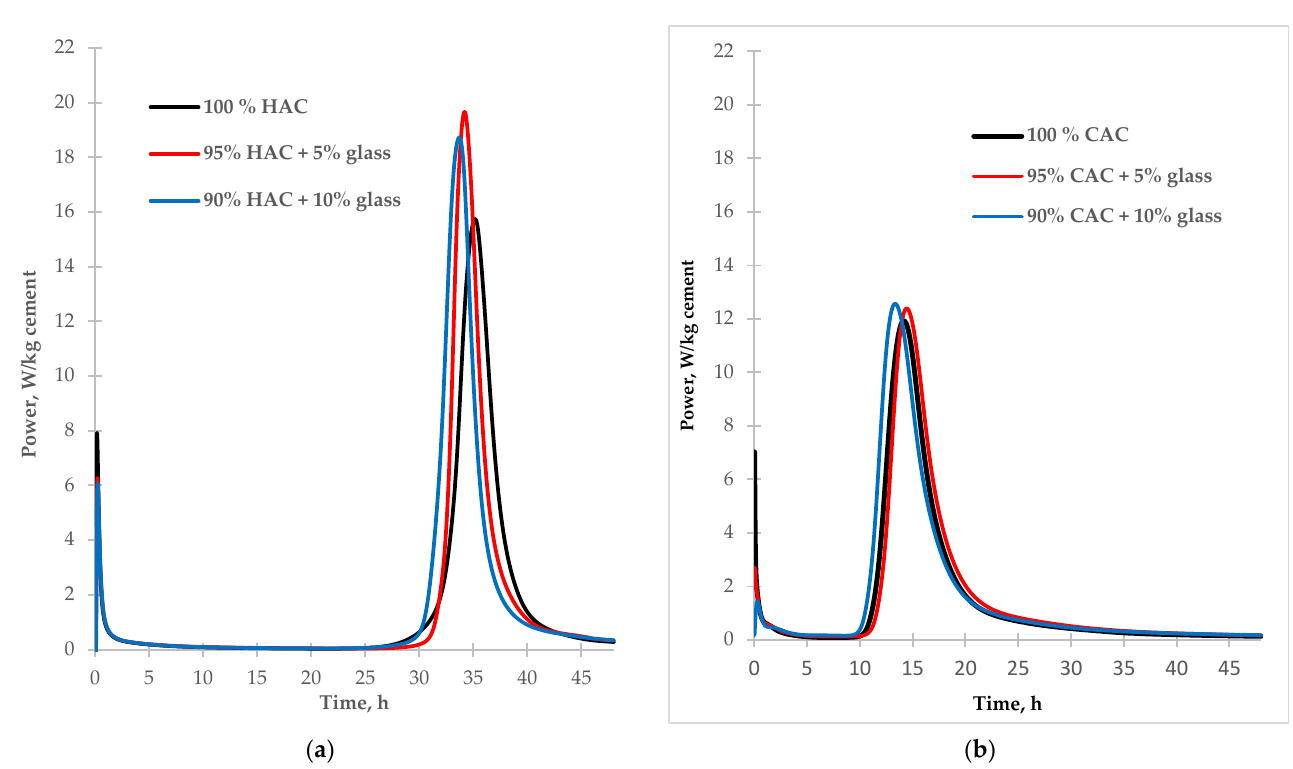
Figure 2. The calorimetric curves of hydration of the tested types of cement HAC ( a ) and CAC ( b ) (with and without glass).